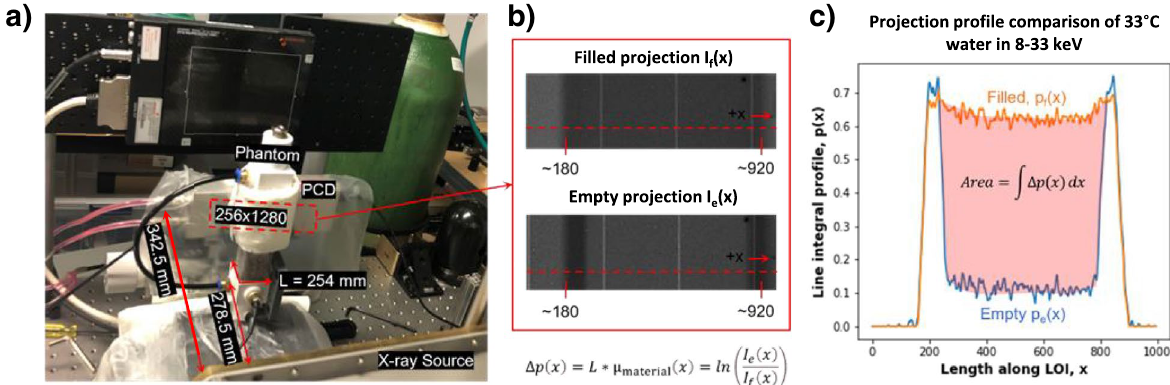
Fig. 1 Illustration of the experimental setup and procedure. a Photo of the photon counting CT configuration used to take 2D projections (256 1280 pixels) of the phantom; b the 200th row in the projection is selected as the line of interest (LOI) and used to obtain the difference × between the projection profiles of the phantom when it is filled and when it is empty. The projections have been contrast enhanced for better viewing and the vertical white lines corresponding to gaps between detector chips are removed during processing; c The difference in area between the projection profiles of the empty and filled phantom are used to determine the LAC of the liquid material